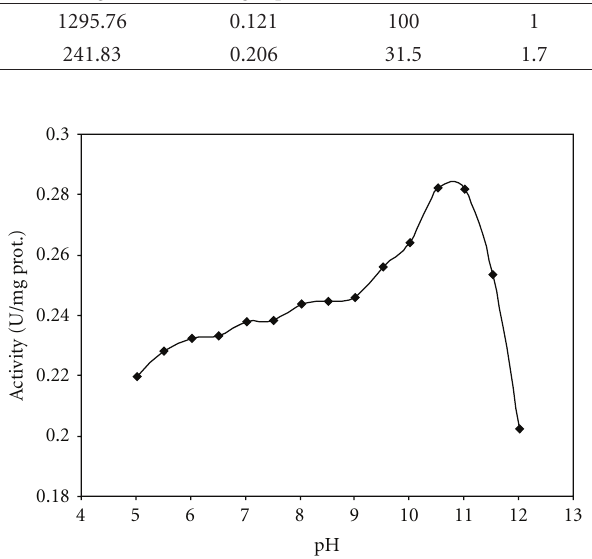
Figure 1: E ff ect of pH on rainbow trout liver rhodanese. The assay mixture contained 25 mM citrate-phosphate-borate bu ff er, at given pH, and 50 mM KCN, 50mM Na 2 S 2 O 3 , and 50 µ L enzyme solution in a total volume of 1.75 mL.